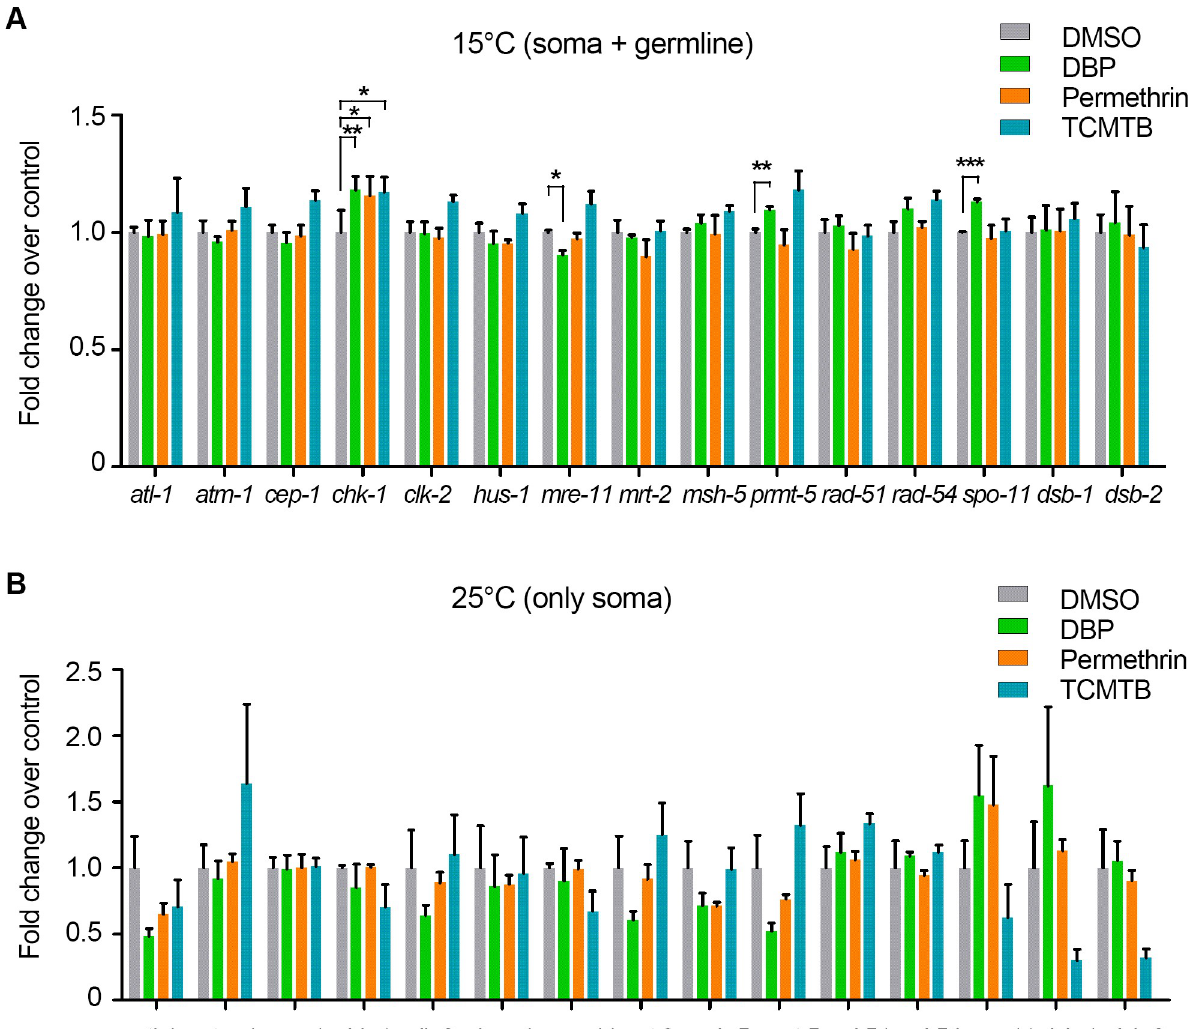
Fig 6. Germline-specific gene expression of DSB formation, repair and response genes is altered by chemical exposures. Expression levels of a panel of genes responsible for DSB formation, repair and DNA damage response were examined by quantitative RT-PCR in glp-1(bn18) ; col-121(nx3) worms that grow without a germline when shifted from 15˚C (A) to 25˚C (B) . Thus, 15˚C represents gene expression in both soma and germline, while 25˚C represents expression only in the soma. The expression levels of 15 critical and conserved genes were measured from either three (15˚C) or four (25˚C) independent biological replicates (each performed with technical triplicates) and normalized to gpd-1 (GAPDH). Y-axis indicates gene expression level change relative to vehicle alone. Error bars represent SEM. � P < 0.05, �� P < 0.01, ��� P < 0.001 by the unpaired two-tailed t -test.